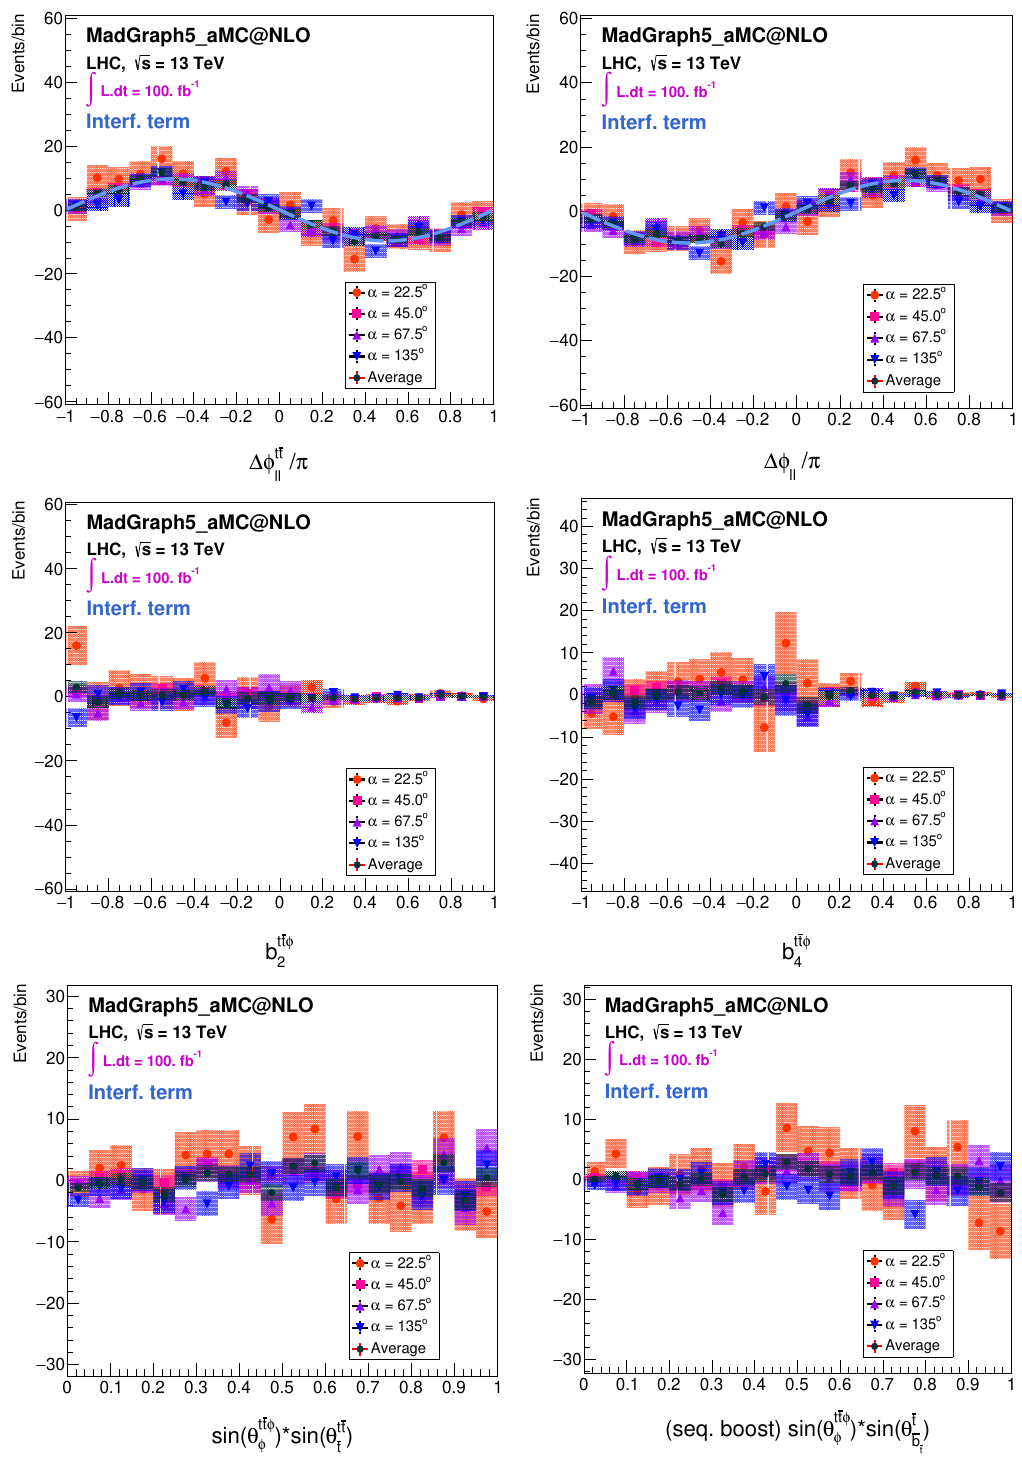
Figure 1 . Interference term at NLO+Shower effects for our choice of the best CP-sensitive variables in t ¯ tφ production at the LHC, for a reference luminosity of 100 fb − 1 . Different t ¯ tφ signals, with mixing angles set to α = 22 . 5 o , 45 . 0 o , 67 . 5 o and 135 o are used to extract the interference